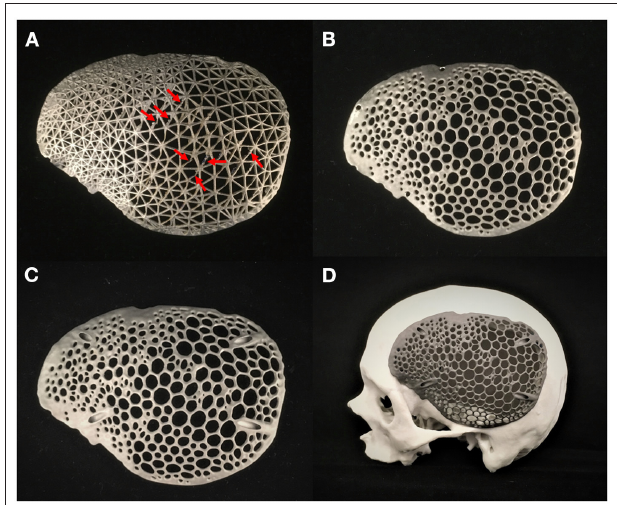
FIGURE 8 | Additively manufactured skull biomodel and biomimetic patient-specific cranial prostheses. (A) Selective laser melting (SLM) 3D printed wireframe pattern prosthesis displaying structural printing issues (red-arrows). (B) Selective laser melting (SLM) 3D printed Voronoi pattern prosthesis with flange screw fixation points. (C) Selective laser melting (SLM) 3D printed Voronoi pattern prosthesis with angular screw fixation points. (D)